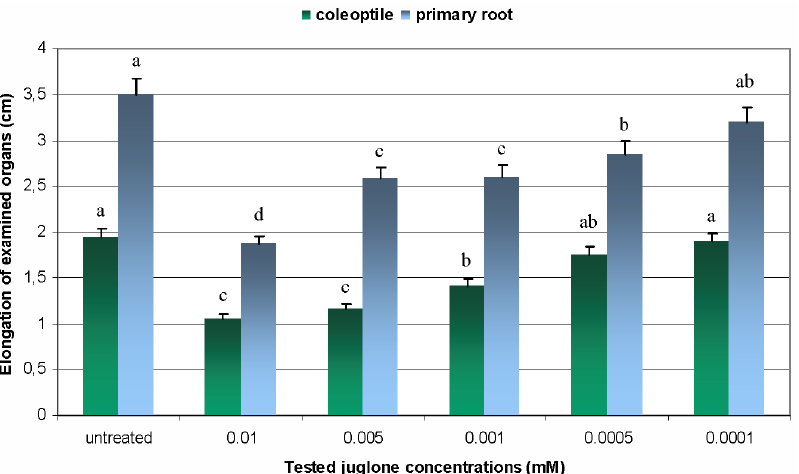
Figure 2. Elongation of coleoptiles and primary roots of juglone-stressed maize seedlings. Values denoted with different letters are statistically significant at p < 0.01 (Duncan’s multiple range test). Parameters were measured at the 8th day of the experiments.